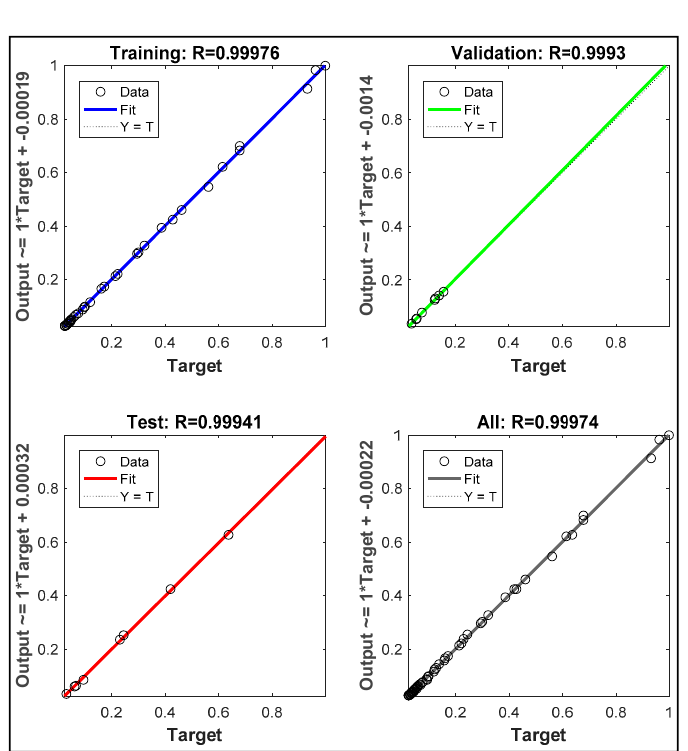
Figure 9. Artificial neural Network (ANN) regression plots for sample X. Energies 2019 , 12 , x FOR PEER REVIEW